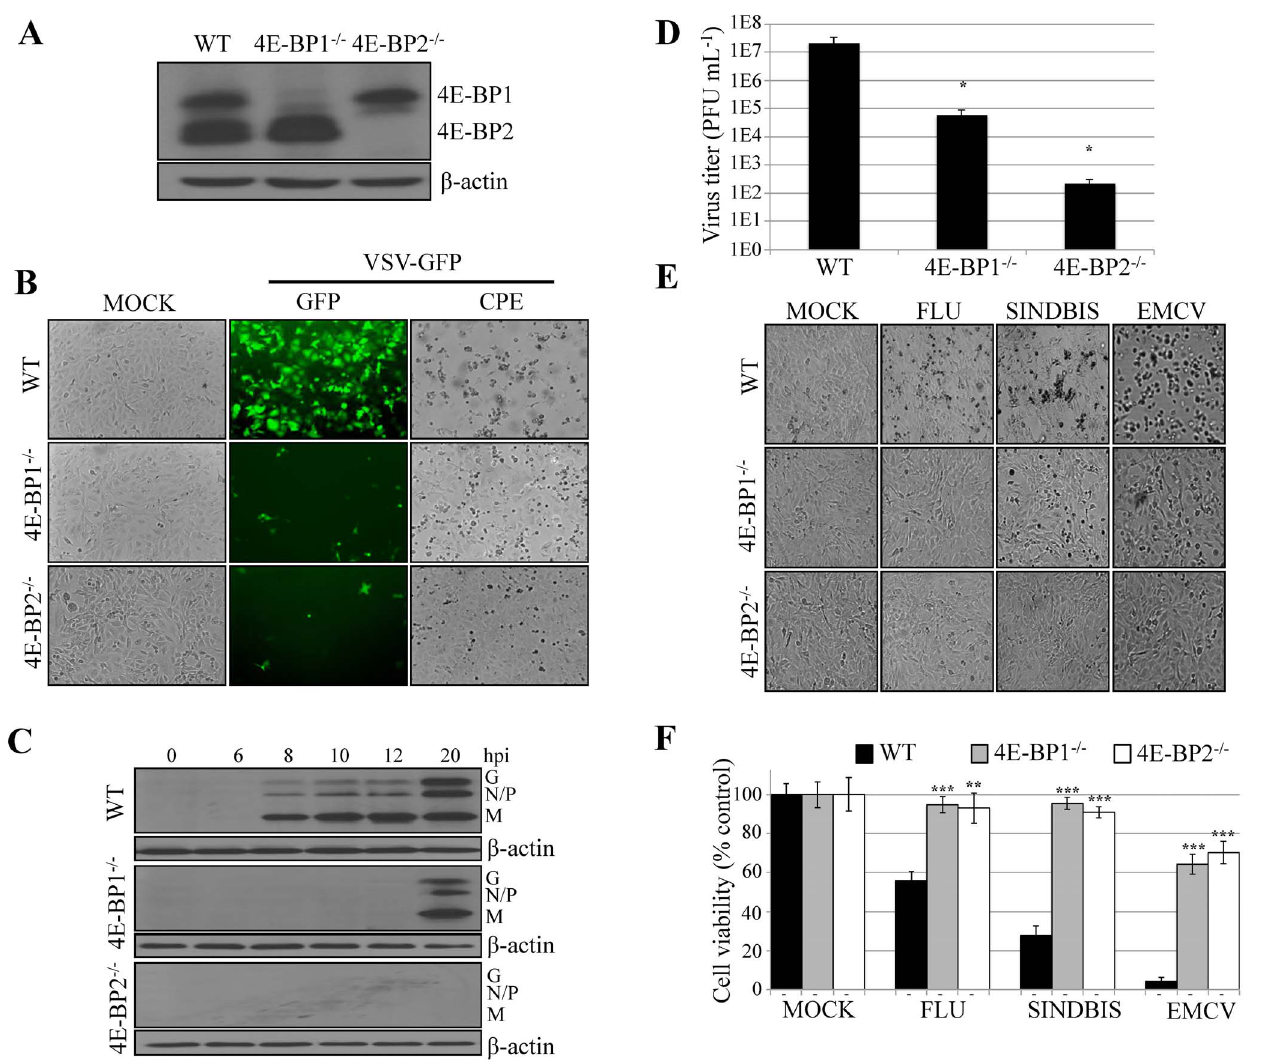
Fig. 2. Lack of 4E-BP1 or 4E-BP2 renders MEFs refractory to VSV infection. (A) Western blotting analysis of 4E-BP1 or 4E-BP2 expression in WT, 4E- BP1 2 / 2 and 4E-BP2 2 / 2 MEFs. b -actin served as a loading control. (B) WT, 4E-BP1 2 / 2 and 4E-BP2 2 / 2 MEFs were mock-infected or infected at a MOI of 1 PFU per cell with VSV-GFP. Twenty-four hpi, viral infection was assessed by GFP fluorescence and CPE. (C) Western blotting analysis for the detection of VSV proteins at the defined time points post-infection of WT, 4E-BP1 2 / 2 and 4E-BP2 2 / 2 MEFs with VSV-GFP at a MOI of 1 PFU/cell. b -actin was used as a loading control. (D) Viral titer quantified by plaque assay at 24 hpi in WT, 4E-BP1 2 / 2 and 4E-BP2 2 / 2 MEFs with VSV-GFP at a MOI of 1 PFU/cell. (E) Photomicrograph of CPE resulting from infections of WT, 4E-BP1 2 / 2 and 4E-BP2 2 / 2 MEFs with FLU, Sindbis and EMCV virus at 1MOI 12 hpi. (F) Cell viability in experiment in (E) was assessed by MTT